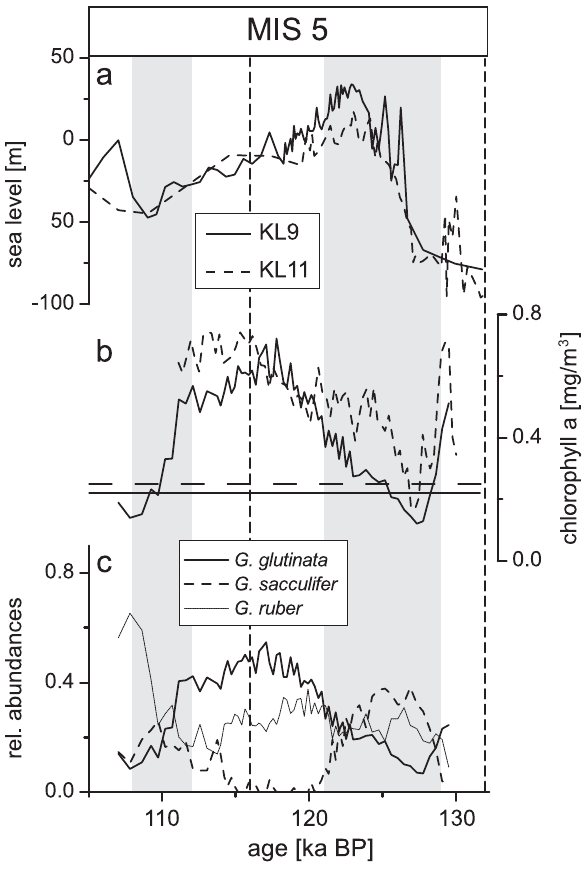
Fig. 5. (a) Sea-level reconstructions from KL9 and KL11 oxy- gen isotopes (Rohling et al., 2008b) based on Siddall et al. (2004), (b) KL9 and KL11 chlorophyll- a reconstructions by the WA-PLS transfer functions approach, and (c) KL9 relative abundances of the three most abundant species: G. glutinata , G. ruber , and G. sac- culifer . Grey bars indicate approximate analogue to present-day periods (112–108ka BP only for KL 9). Dashed vertical lines mark MIS-boundaries.